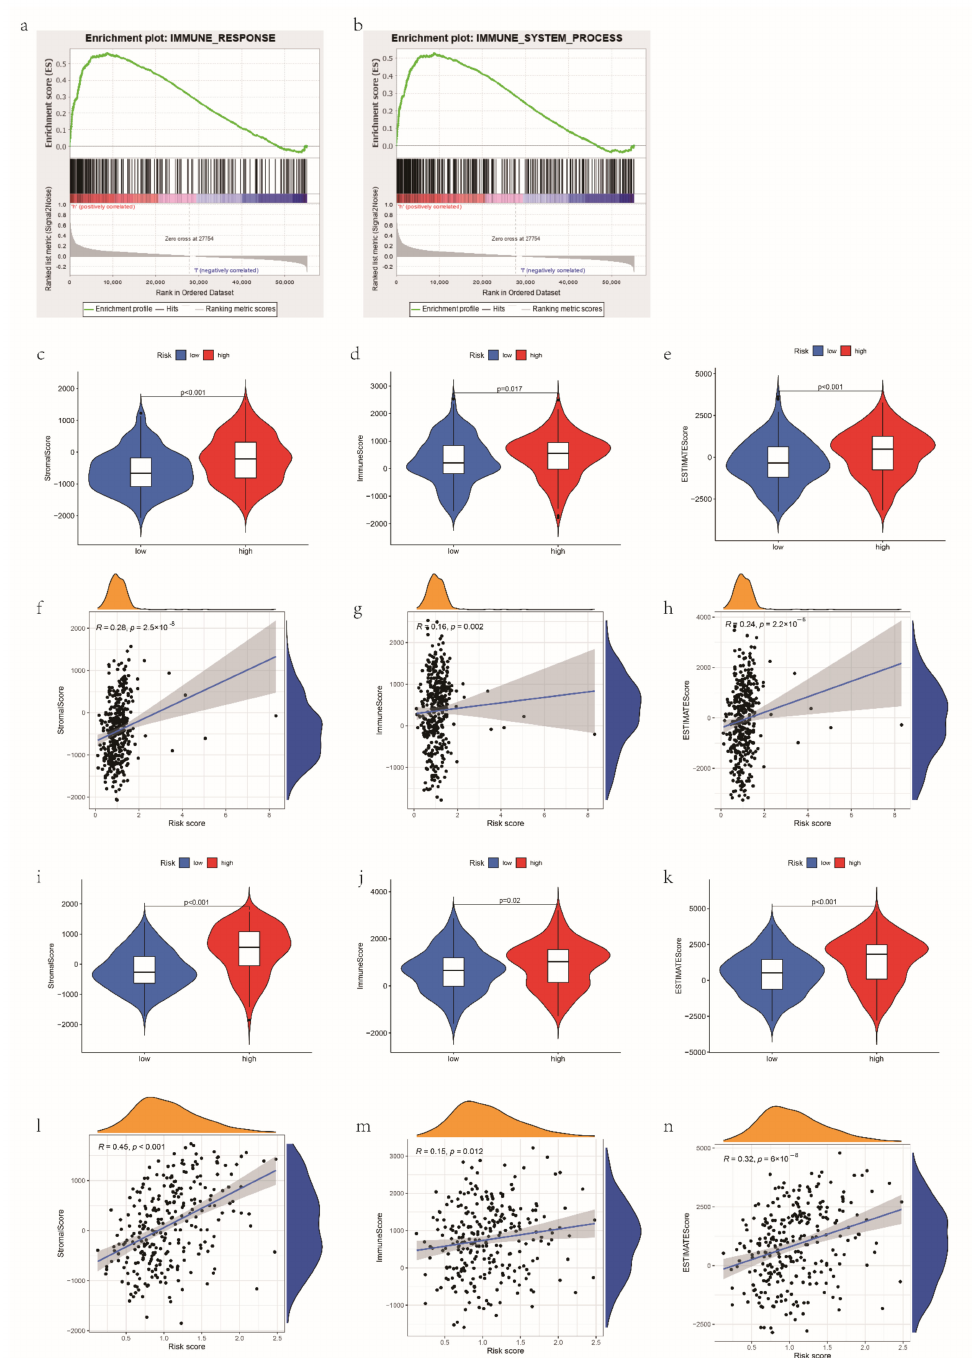
Figure 4. The correlation between risk score and immune features in the TCGA dataset. ( a , b ) GSEA showed that immune response and immune system process were enriched in the high-risk